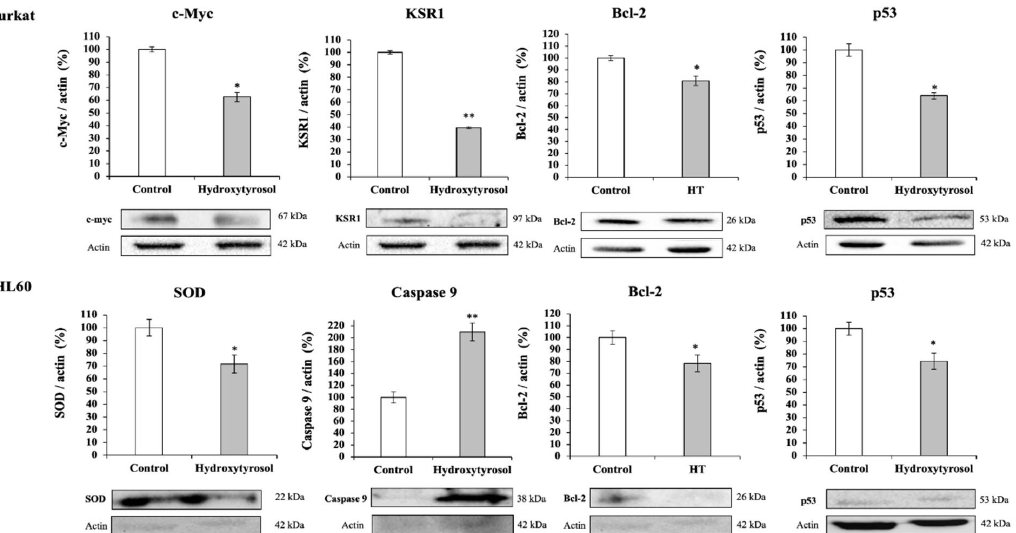
Figure 6. Effect of hydroxytyrosol (HT) on the expression levels of different marker proteins for cell proliferation and differentiation (c-Myc, KSR1), apoptosis (Bcl-2, p53, Caspase 9) and cellular oxidative stress (SOD) in Jurkat and HL60 cell lines controls and exposed to the IC 50 concentration of HT for 24 h in Jurkat cells and 72 h in HL60 cells. Quantification of protein levels by densitometric analysis is shown in bar graphs. Results are means ± SEM ( n = 9) and are expressed as percentage of expression compared to actin levels in Western-blot analysis. The presence of the asterisk indicates significant differences between the control and treated cells (* p < 0.01; ** p < 0.001). KSR1, Kinase suppressor of Ras 1; Bcl2, Anti-apoptotic B-cell lymphoma 2; SOD, Superoxide dismutase.